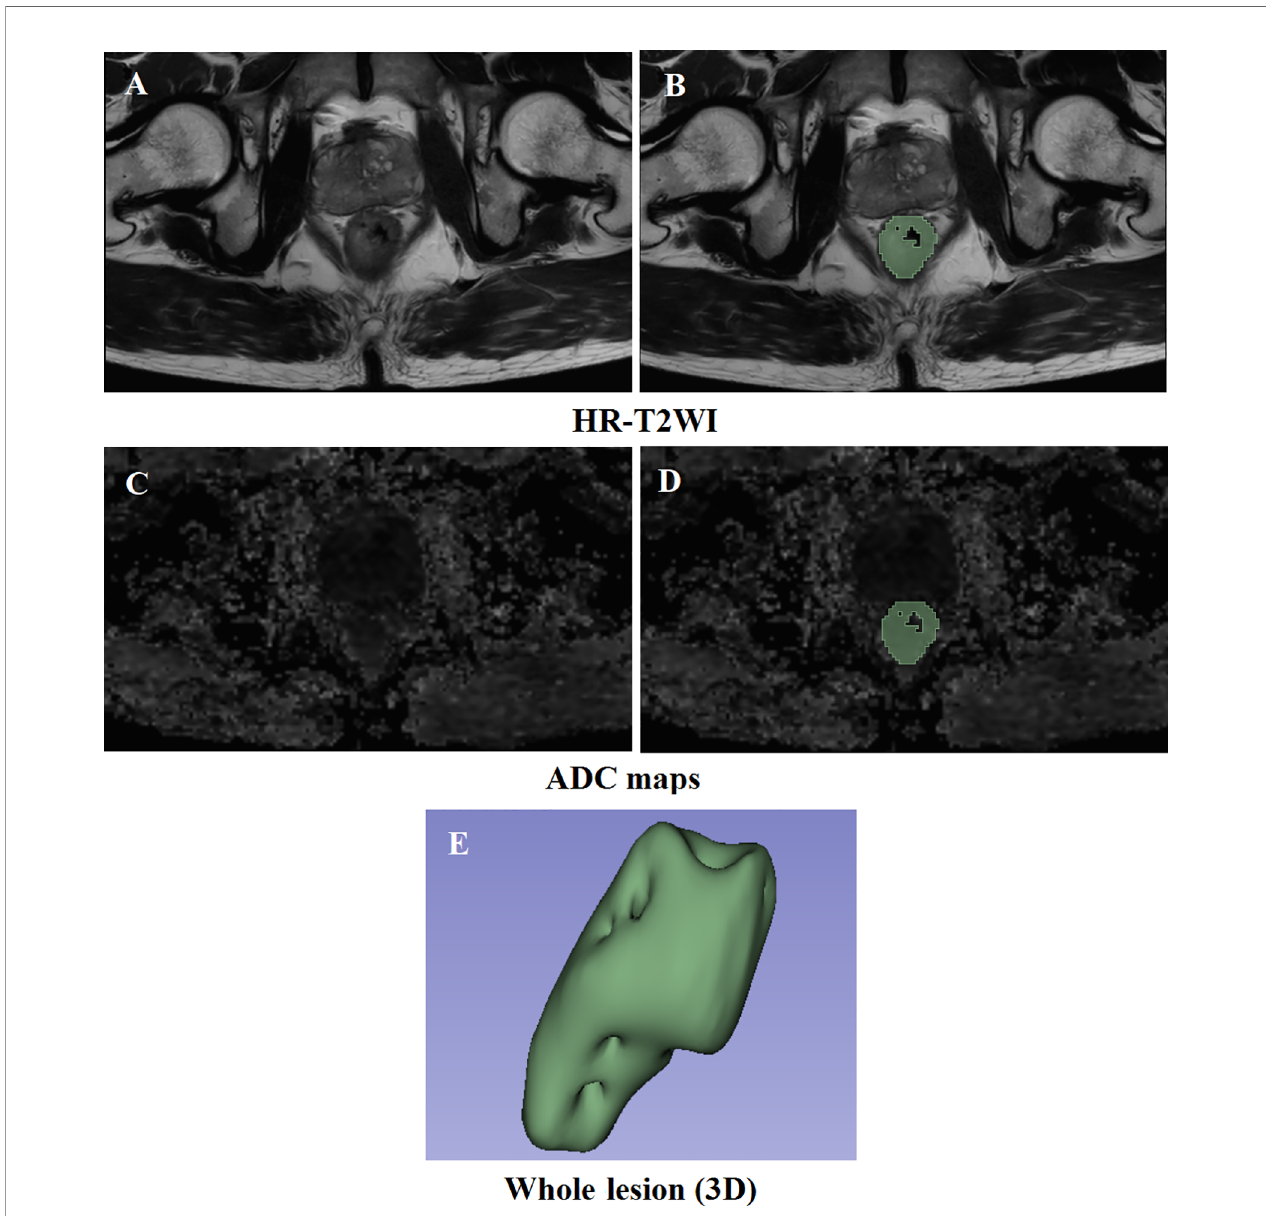
FIGURE 2 | Results of the delineation of the VOI. (A, C) High-resolution T2-weighted imaging and apparent diffusion coef fi cient maps at the same slice level, respectively. (B, D) The result of lesion segmentation. The green marked part is the delineated lesion. (E) The three-dimensional label of the whole